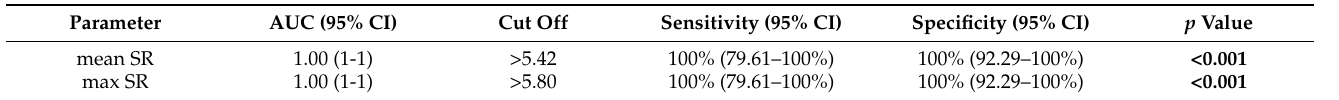
Table 2. ROC analysis of mean and max SR values for differentiation between adenomyosis from controls.